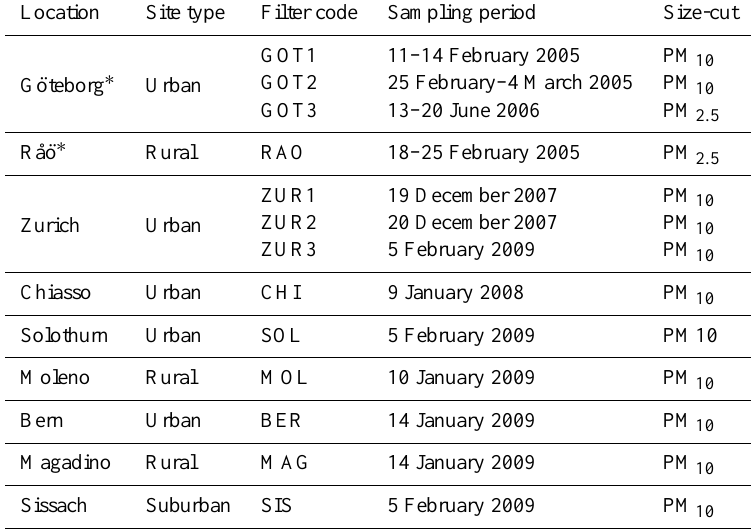
Table 1. Information on the filters analysed in this study.